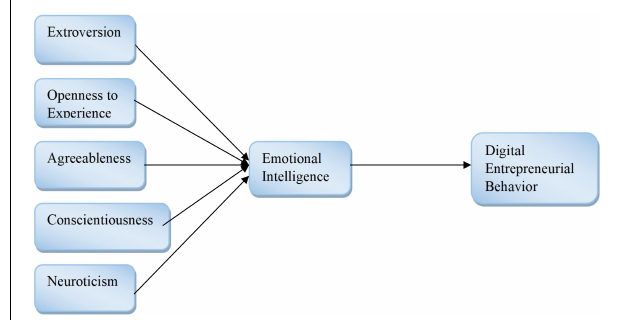
FIGURE 2 | Conceptual